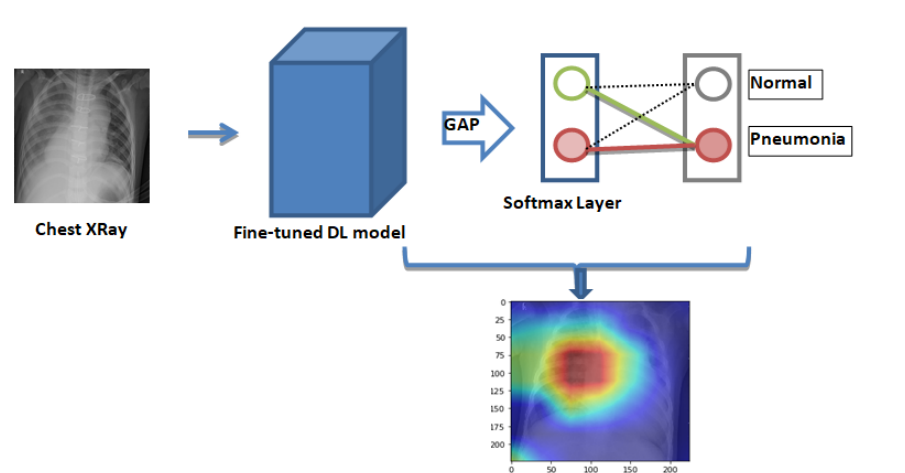
Figure 7. Generation of the class activation map for fine-tuned deep learning models. The layers of deep learning models are followed by the global average pooling layer (GAP) ( ⇒ ) and the softmax layer to give the final prediction. Features that are used for pneumonia detection get highlighted in the class activation